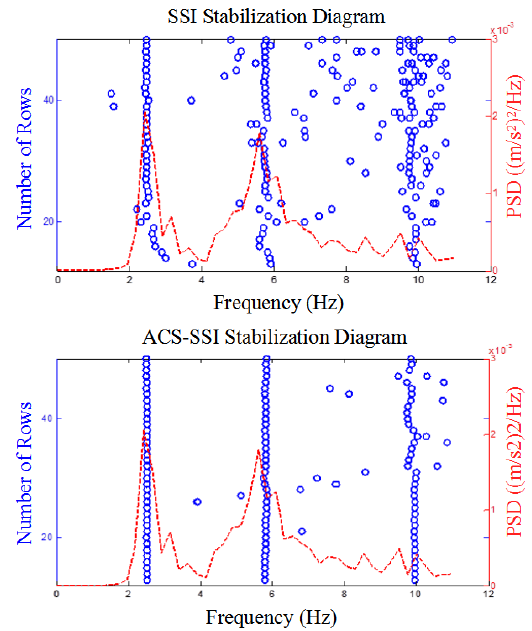
Figure 4. Identification stabilization diagrams of ACS-SSI and SSI. PSD: Power Spectral Density